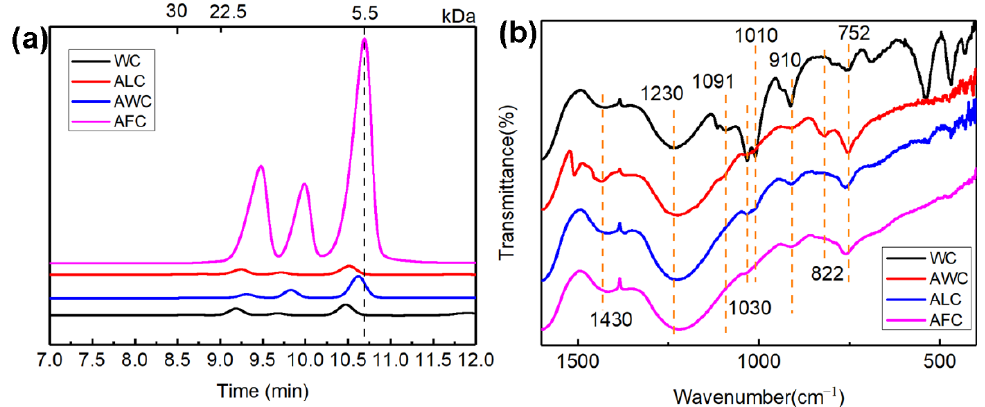
Figure 5. Humic acid molecular weight distribution ( a ) and IR ( b ) spectra of four different treat-